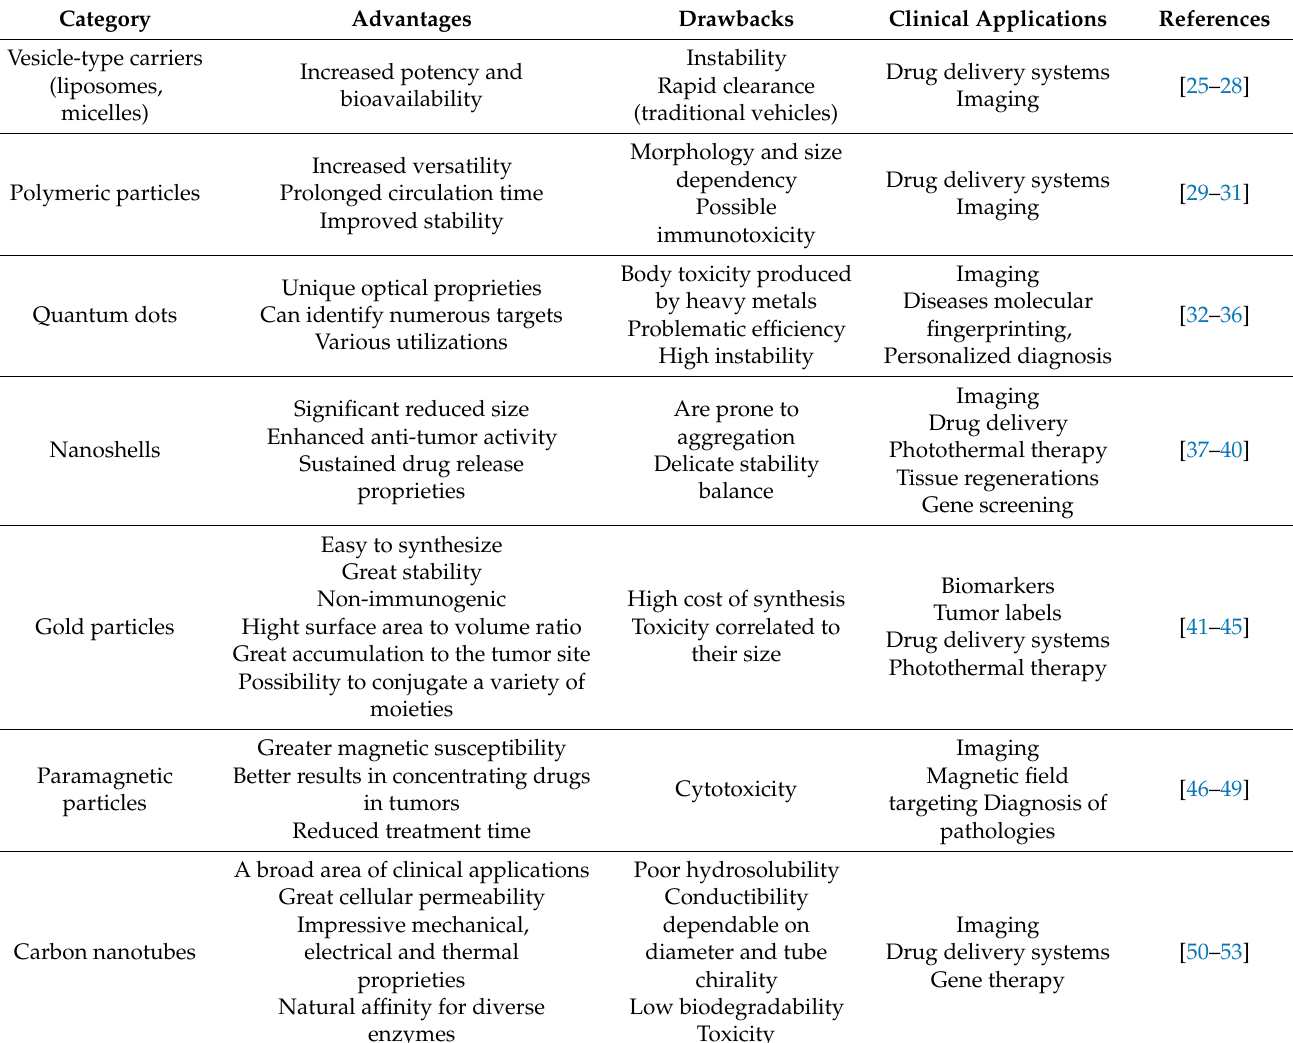
Table 1. Types of nanocarriers used in imaging.